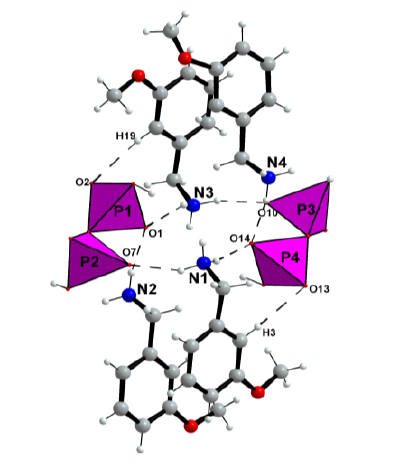
Figure 3. Topology of H-bond scheme in [3-(CH